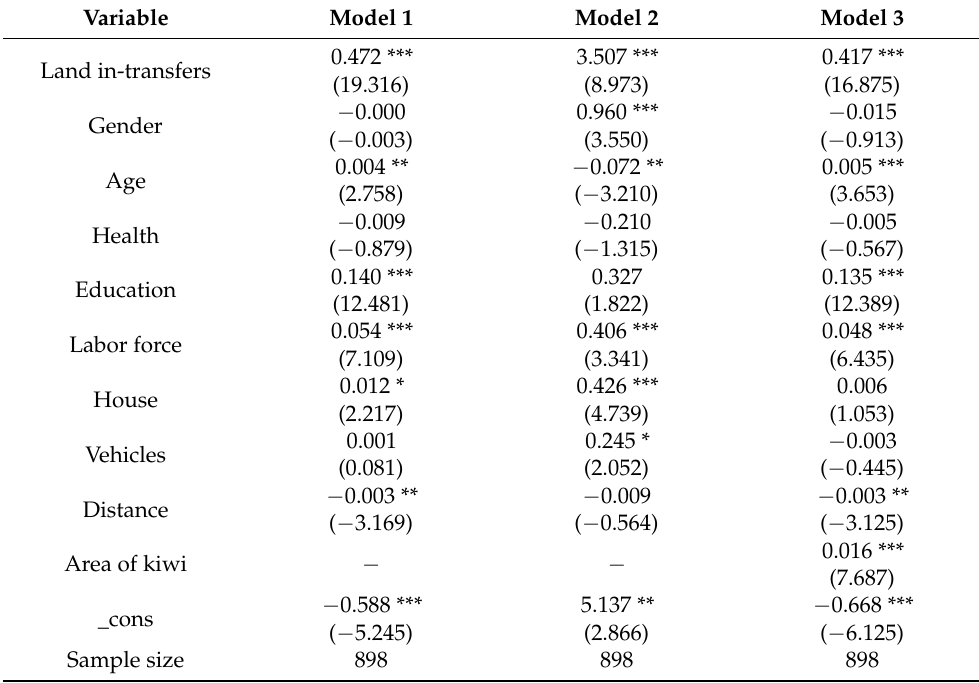
Table 5. Results of the benchmark model and mediating